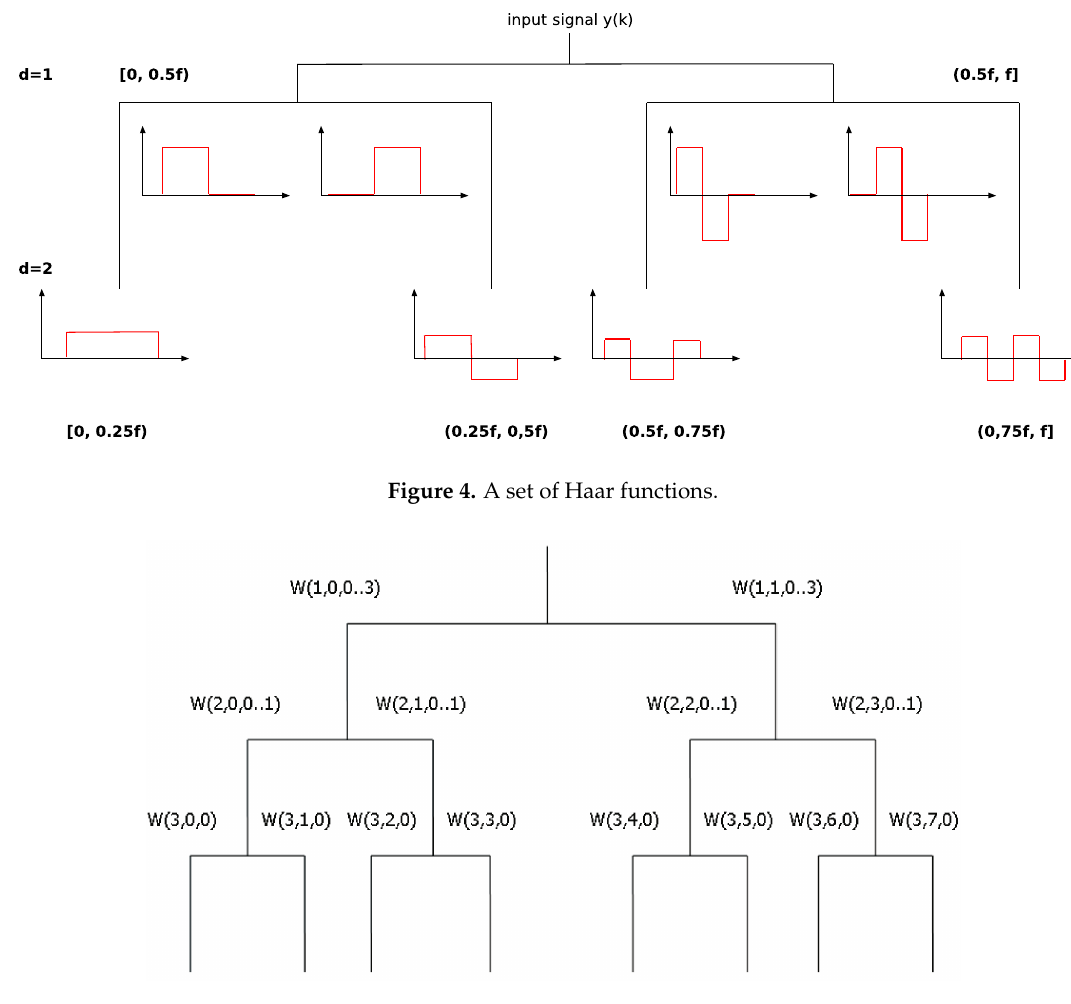
Figure 5. Wavelet coefficients arranged in a